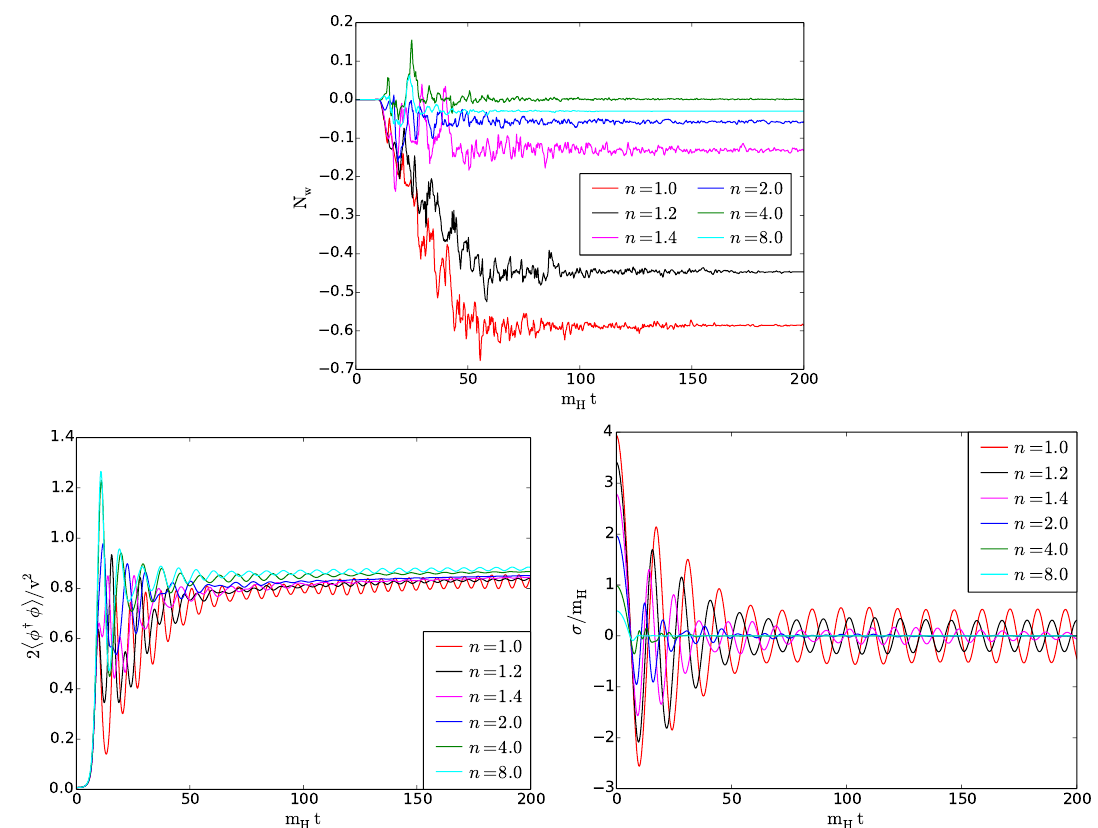
Figure 6 . The evolution of Higgs winding number (top), Higgs (cid:12)eld (bottom left), and singlet (cid:12)eld (bottom right) for di(cid:11)erent n .